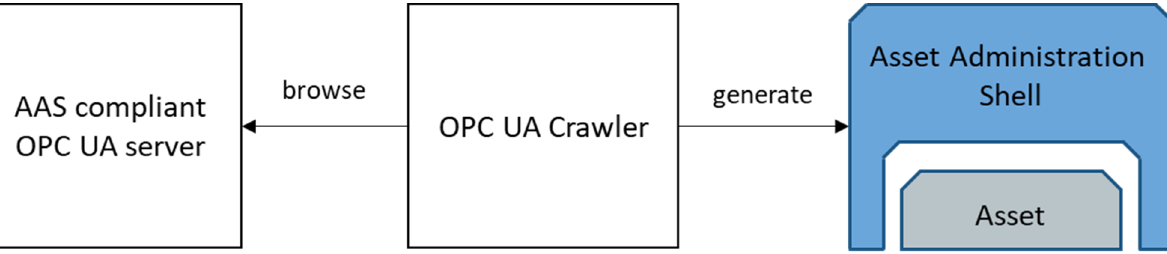
Figure 6. Concept of the OPC UA Crawler.